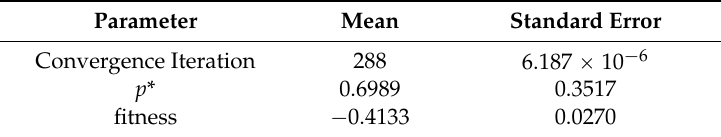
Figure 9. The evolution of global fitness. Table 5. The statistics data for the PSO algorithm.